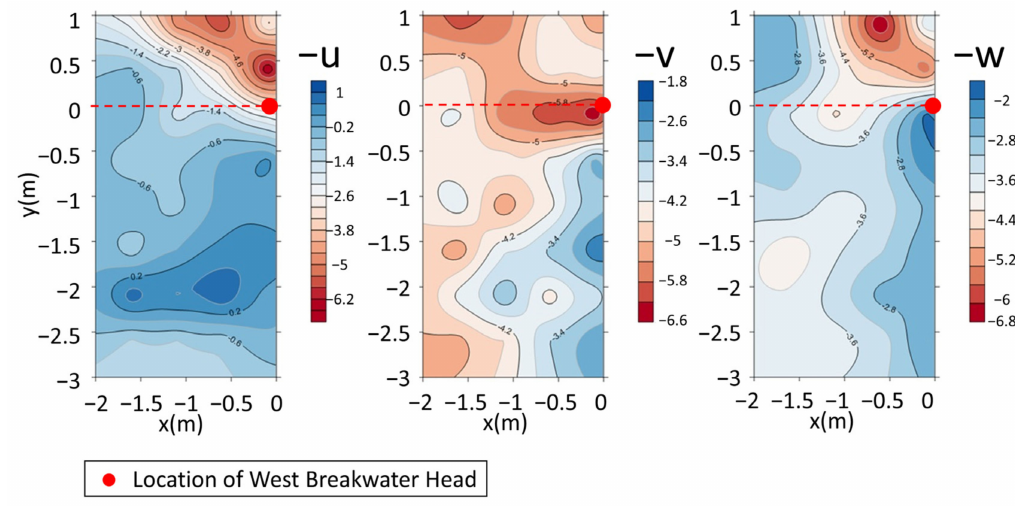
Figure 21. Max u, v, w at west side of the West Breakwater (z = − 10 m).